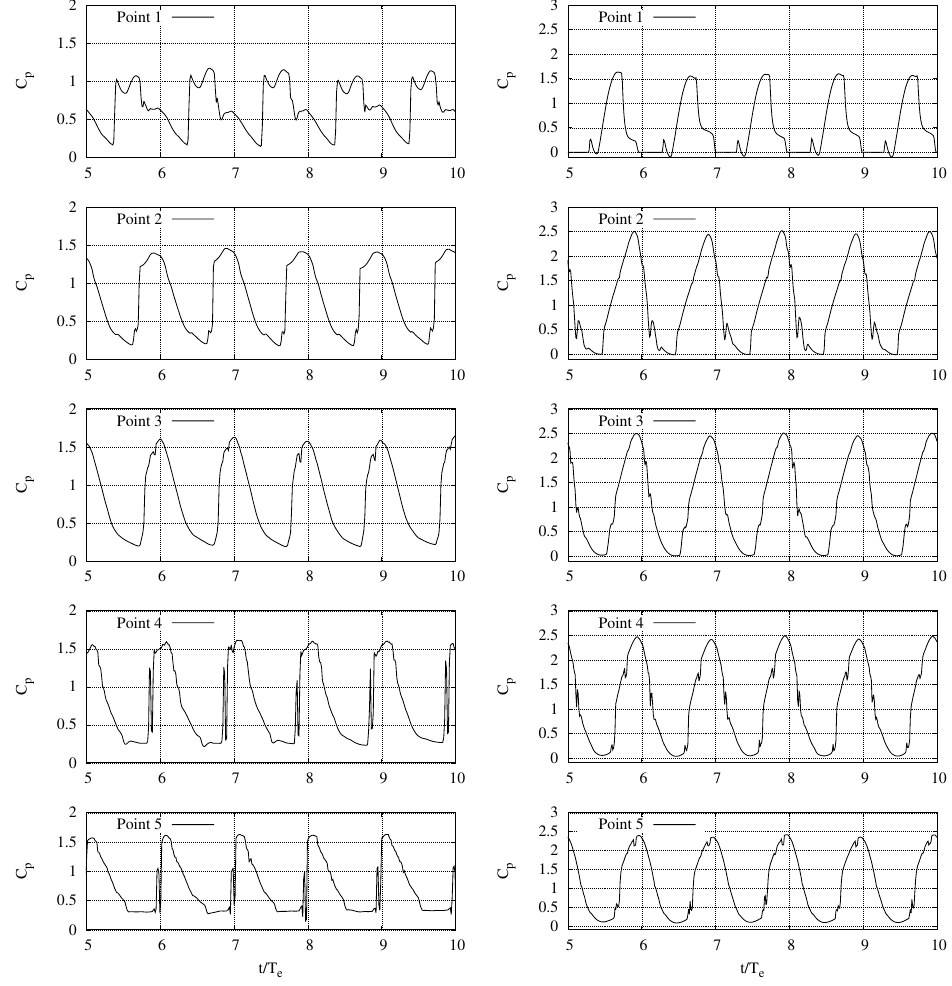
Figure 10. Time histories of the pressure at five monitoring points for λ / L = 0.9 (left column) and 1.3 (right